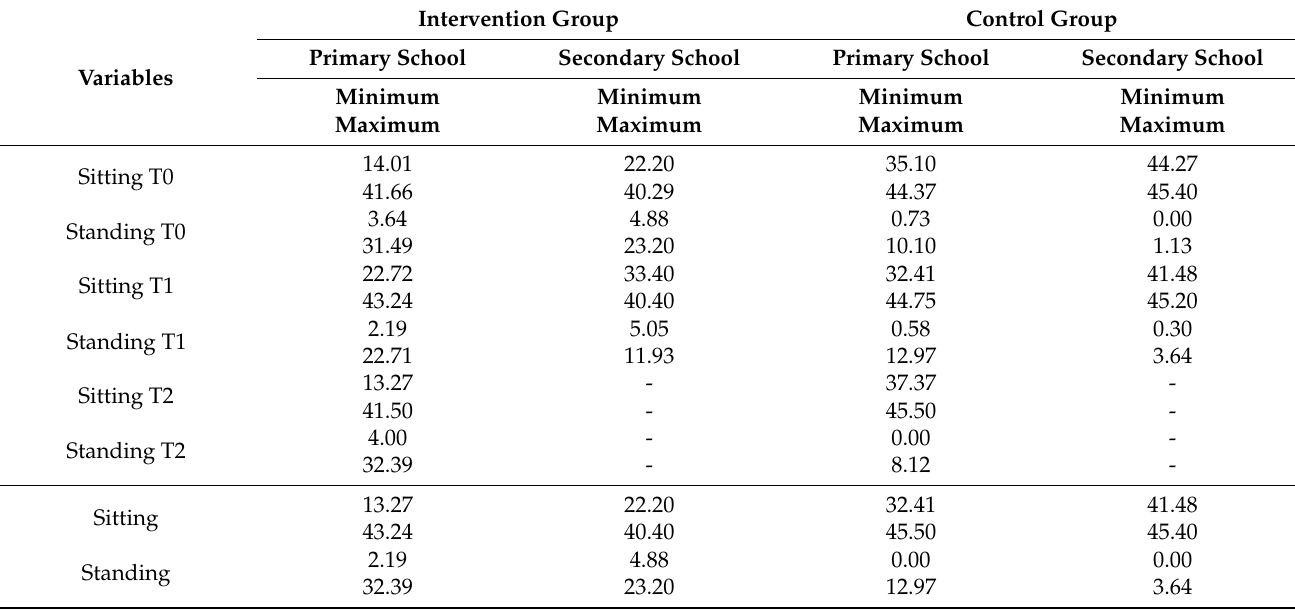
Table A1. Variability among individual children regarding sitting and standing